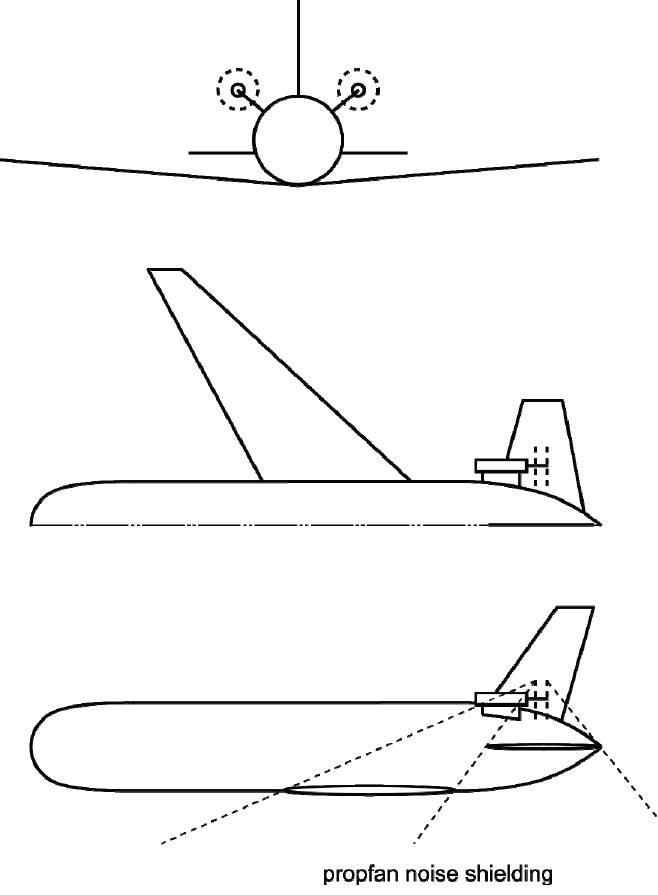
Figure 19. Low-noise cruise-efficient aircraft configuration II: open-rotor.